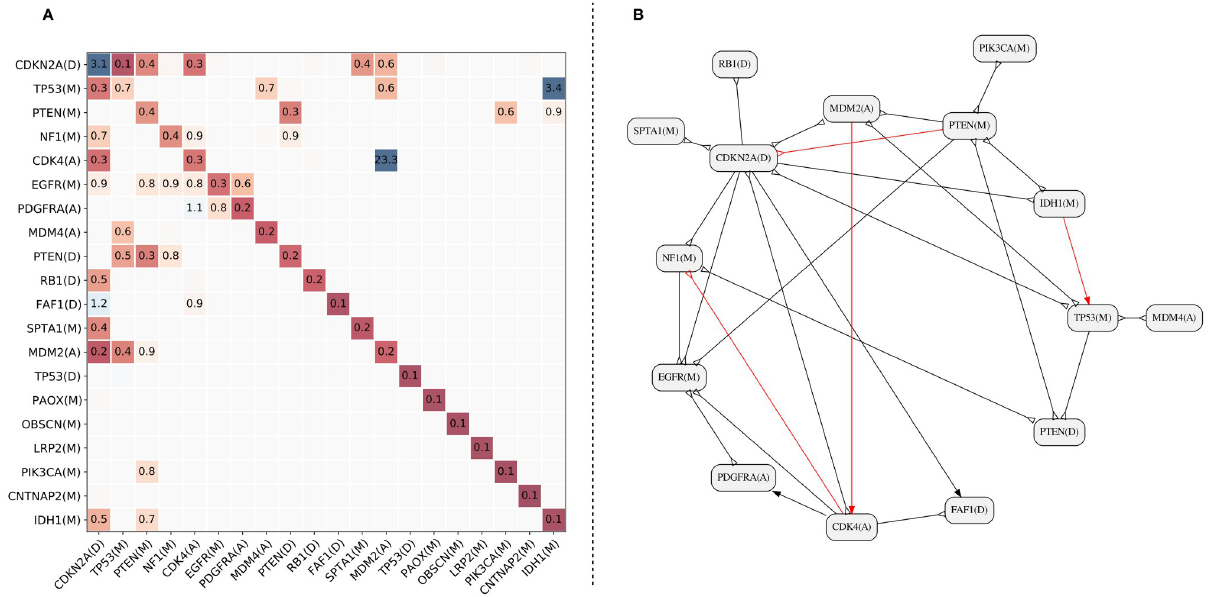
Fig 6. MHN result for the pathTiMEx Glioblastoma dataset. A . The matrix of base rates and multiplicative factors. B . The corresponding graph. Note that the disconnected nodes are not plotted.